Question: What kind of plot is shown here?
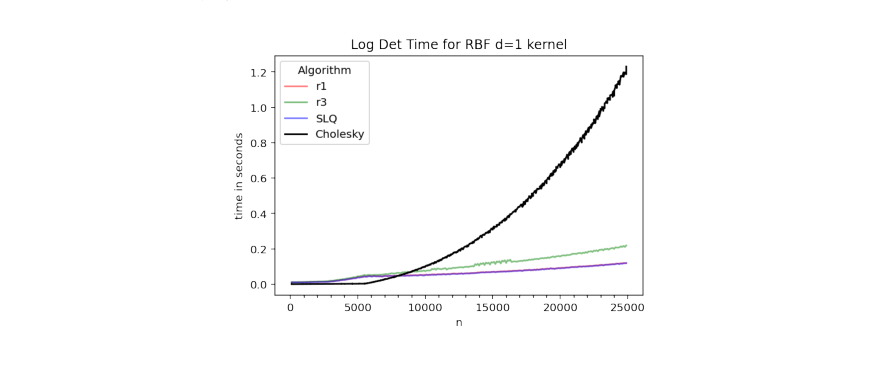
Answer: line